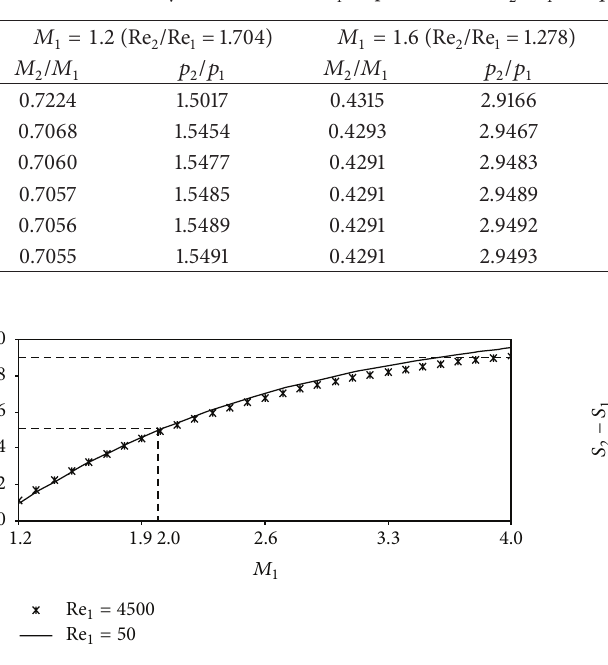
, dependence of 𝑀 2 / 𝑀 1 and 𝑝 2 / 𝑝 1 for different values of 𝑀 1 and Re 1